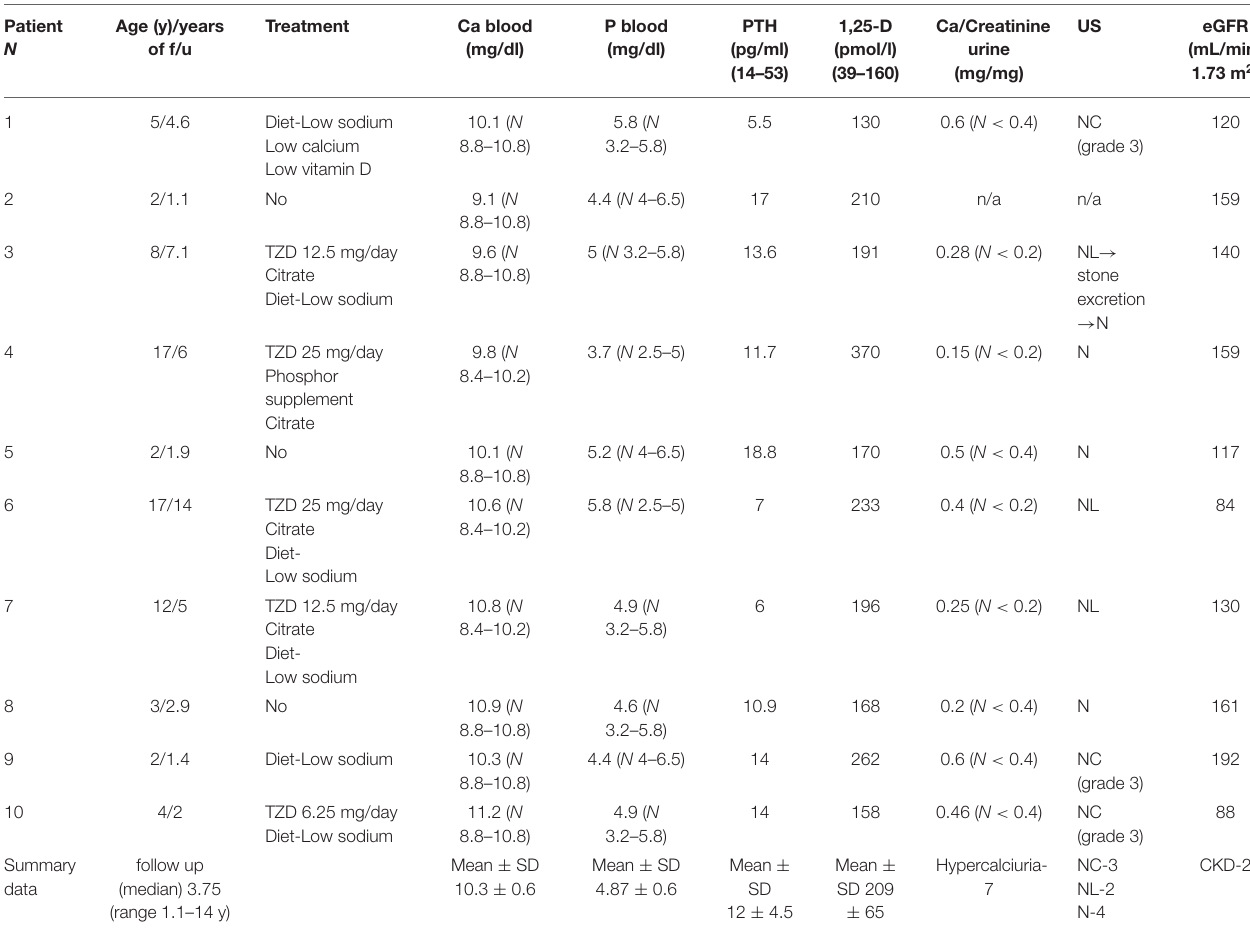
TABLE 2 | Clinical and laboratory data at the last follow up visit. Patient